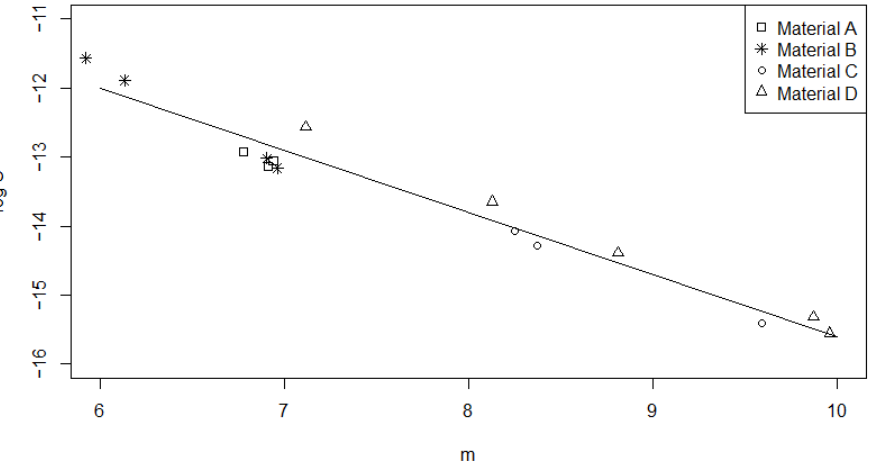
Figure 10. Linear correlation between the parameters log C and m describing the kinetics of fatigue crack growth; the samples from the plastically deformed Material B are marked by asterisks.